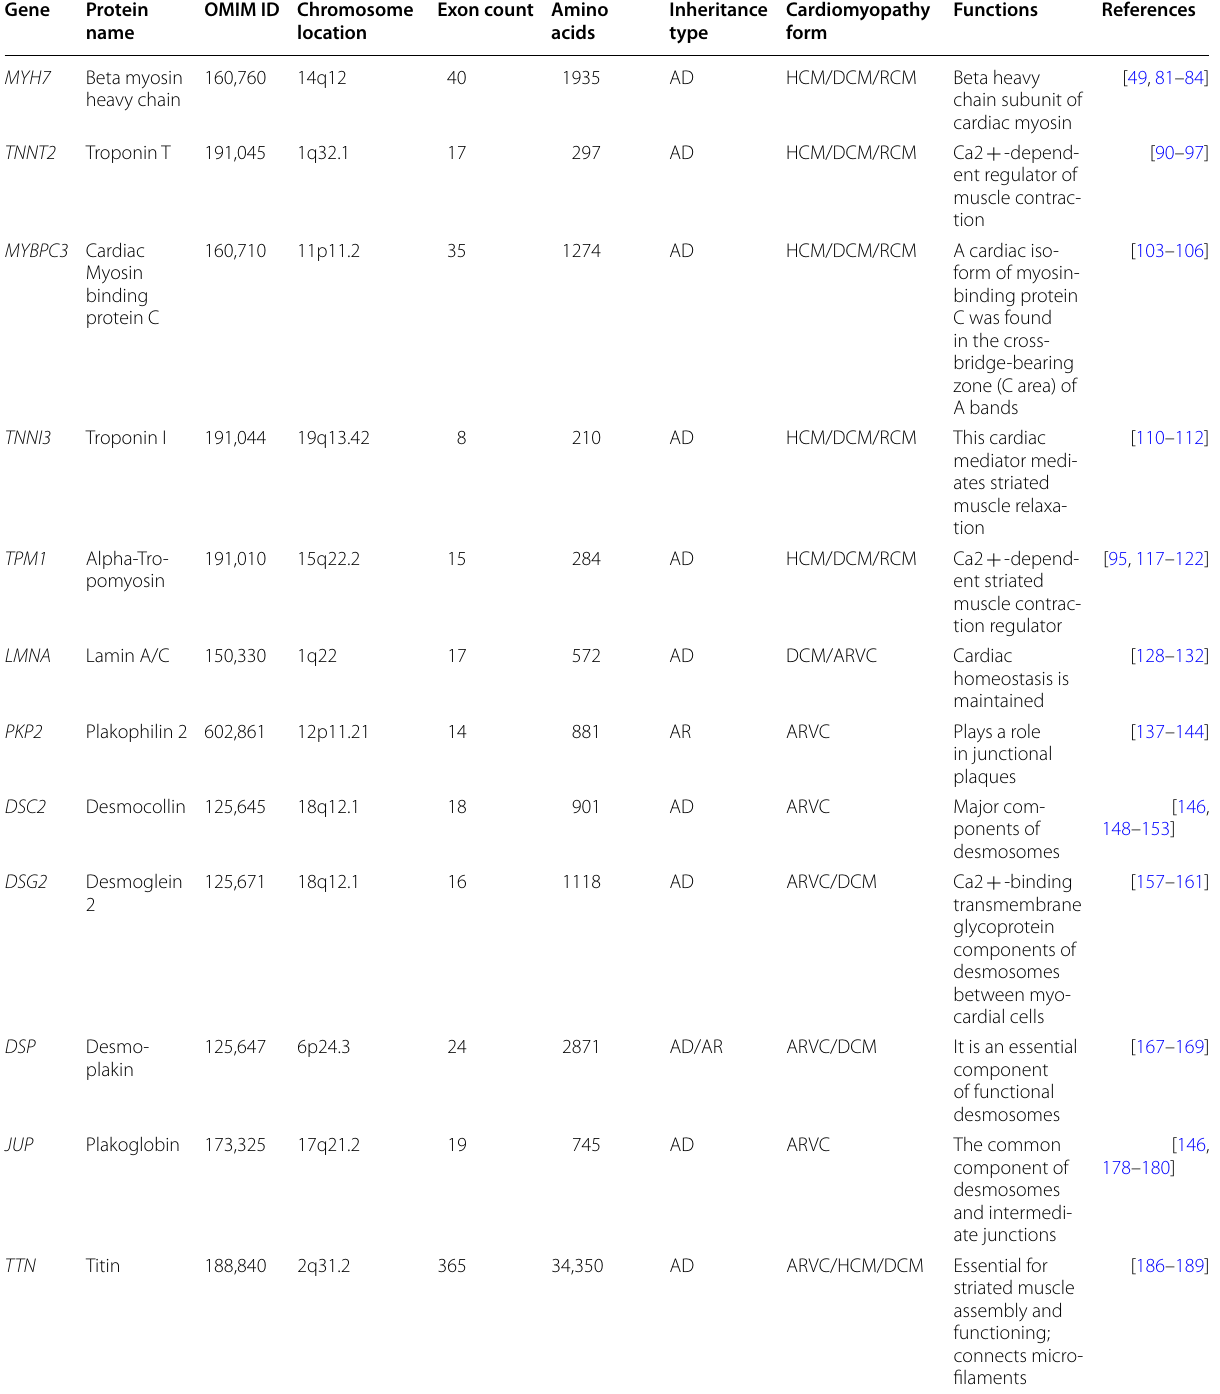
Table 2 Significant genes associated with